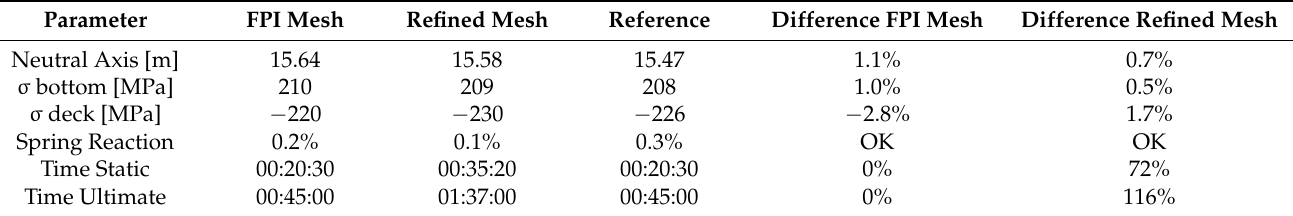
Table 9. Sensibility analysis for different mesh